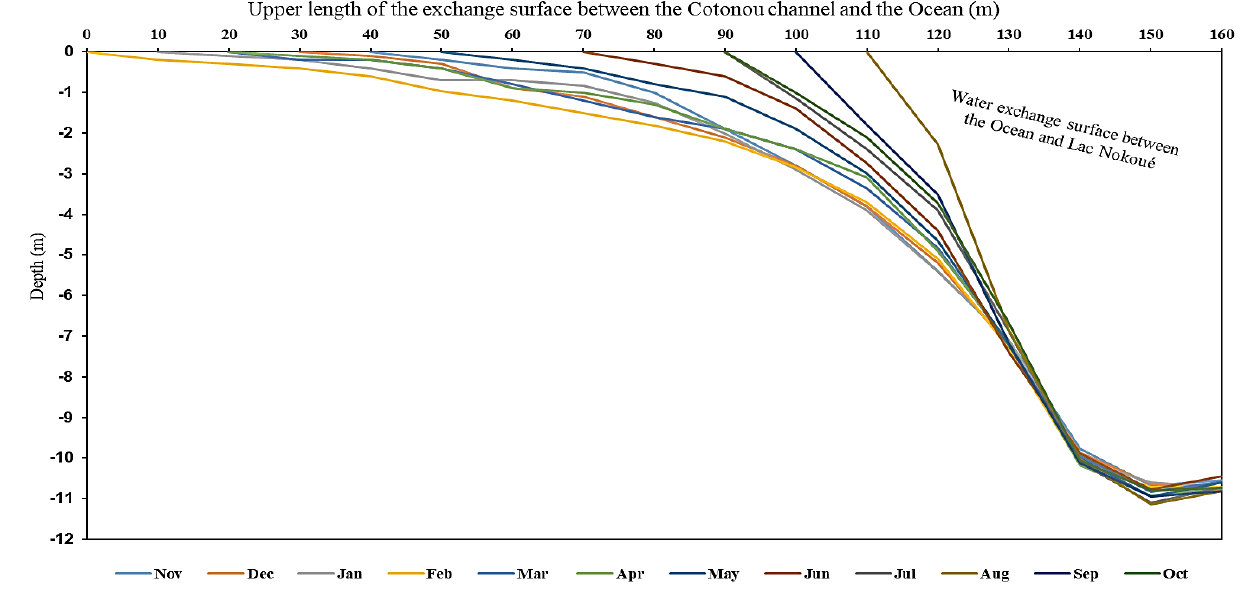
Figure 6. Variation of the exchange surface between the sea and Lake Nokoué.